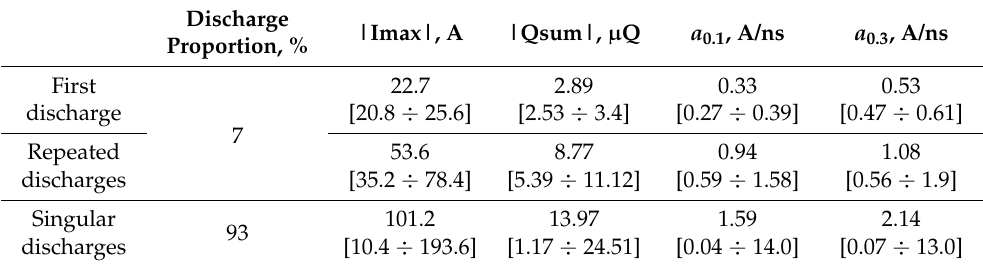
Table 1. Parameters of main stage discharge current pulses from a single artificial thunderstorm cell of positive polarity involving one group of model hydrometeors (mean value,